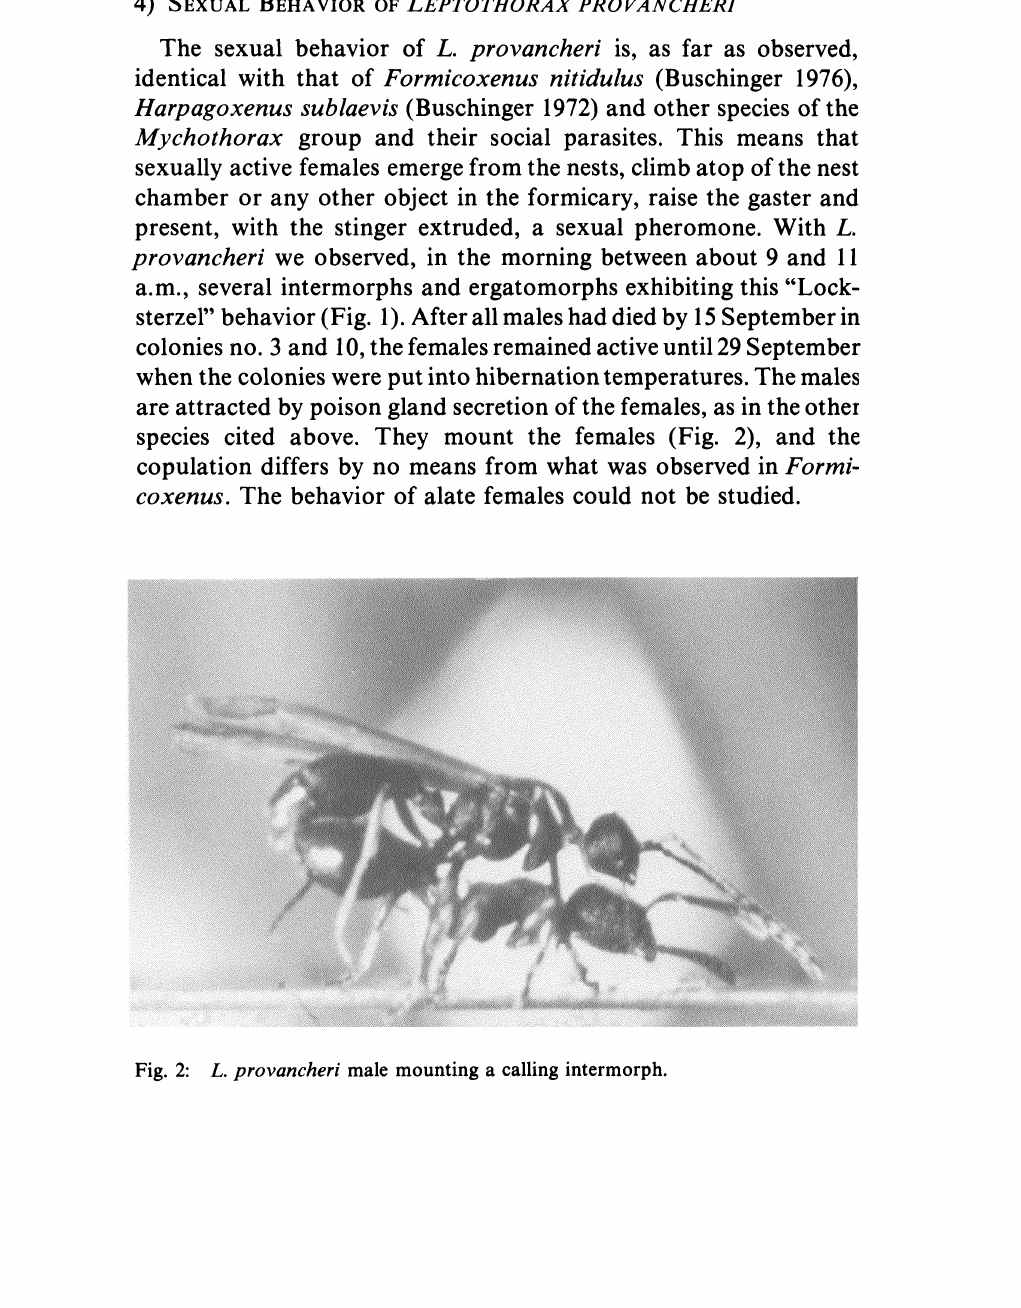
Fig. 2: L. provancheri male mounting a calling